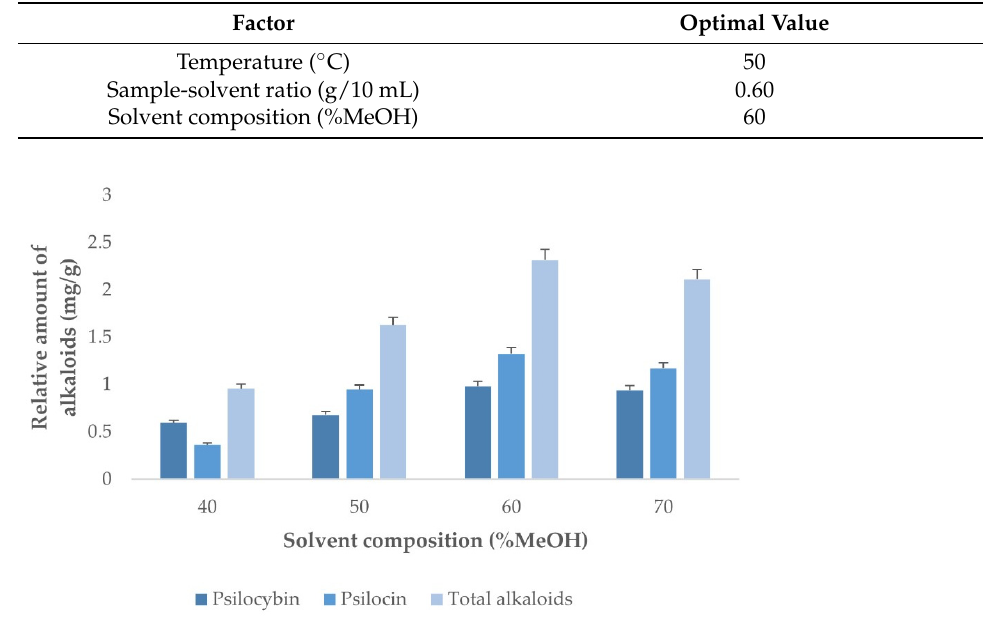
Figure 6. Alkaloids extraction yields obtained when using different solvent compositions (wa ‐ ter:methanol) under the established optimal temperature and sample ‐ to ‐ solvent ratio values ( n = 2). As it can be observed, the optimal temperature obtained concurs with the minimum value studied. Lower temperature levels could not be tested since the extraction equip ‐ ment used cannot operate under 50